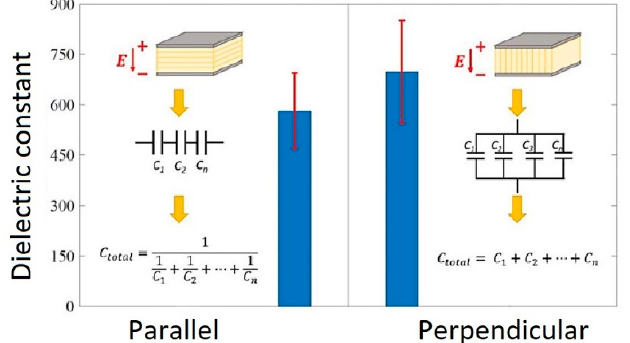
Figure 21. Comparison of average dielectric constant and standard deviation at 1 kHz (Reprinted from Ref. [102], copyright (2019), with the kind permission of IOP Publishing Ltd.).